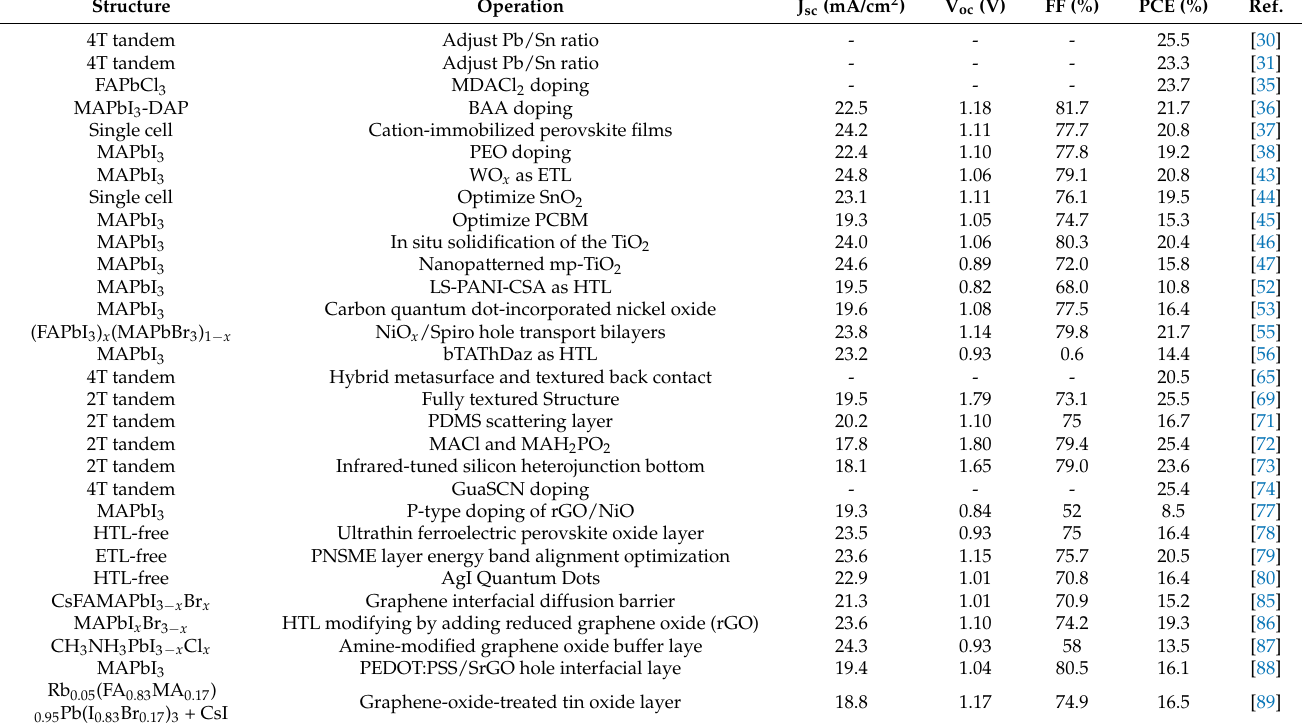
Table 1. Influence of PSC structure and operation on device